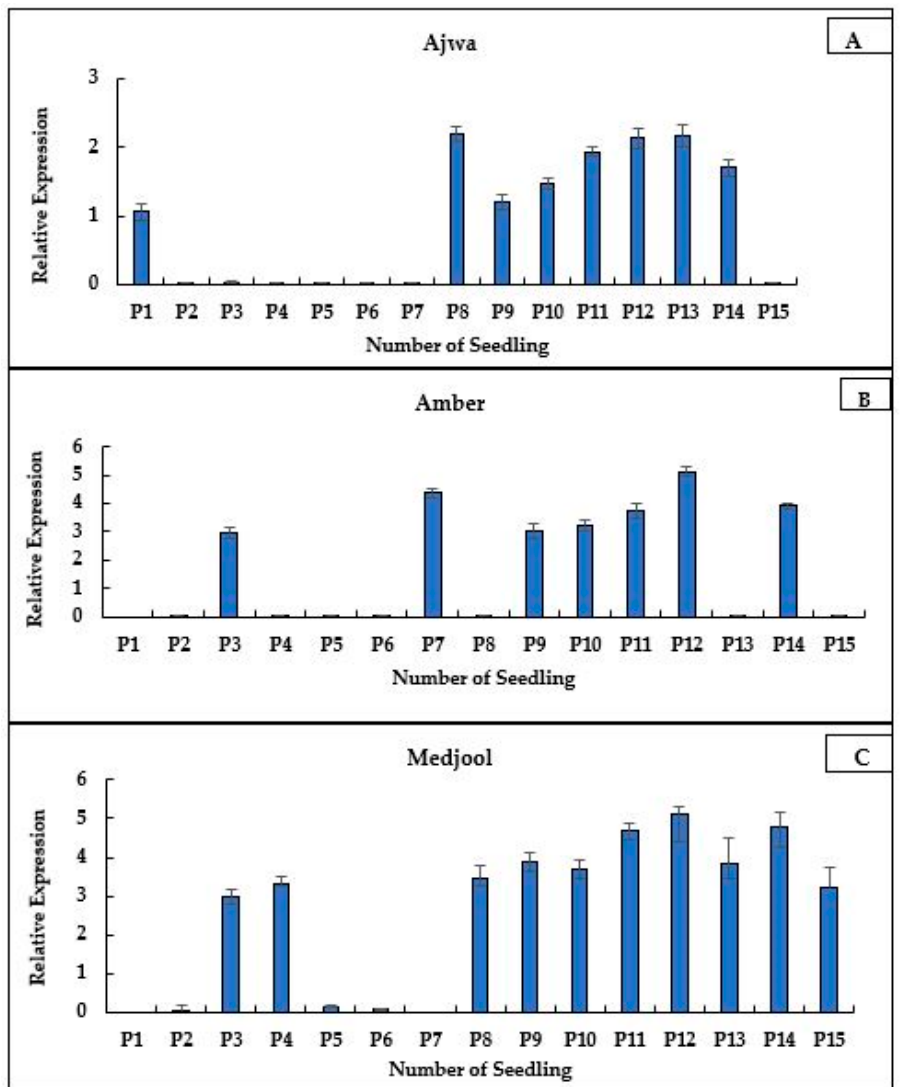
Figure 5. Expression profiling of TPD1-like in unknown seedlings of date palm. Error bar indicates ± SE of three experimental replicates. ( A ) is showing expression of TPD1-like gene in Ajwa, ( B ) is showing expression of TPD1-like gene in Amber and ( C ) is showing expression of TPD1-like gene in Medjool.